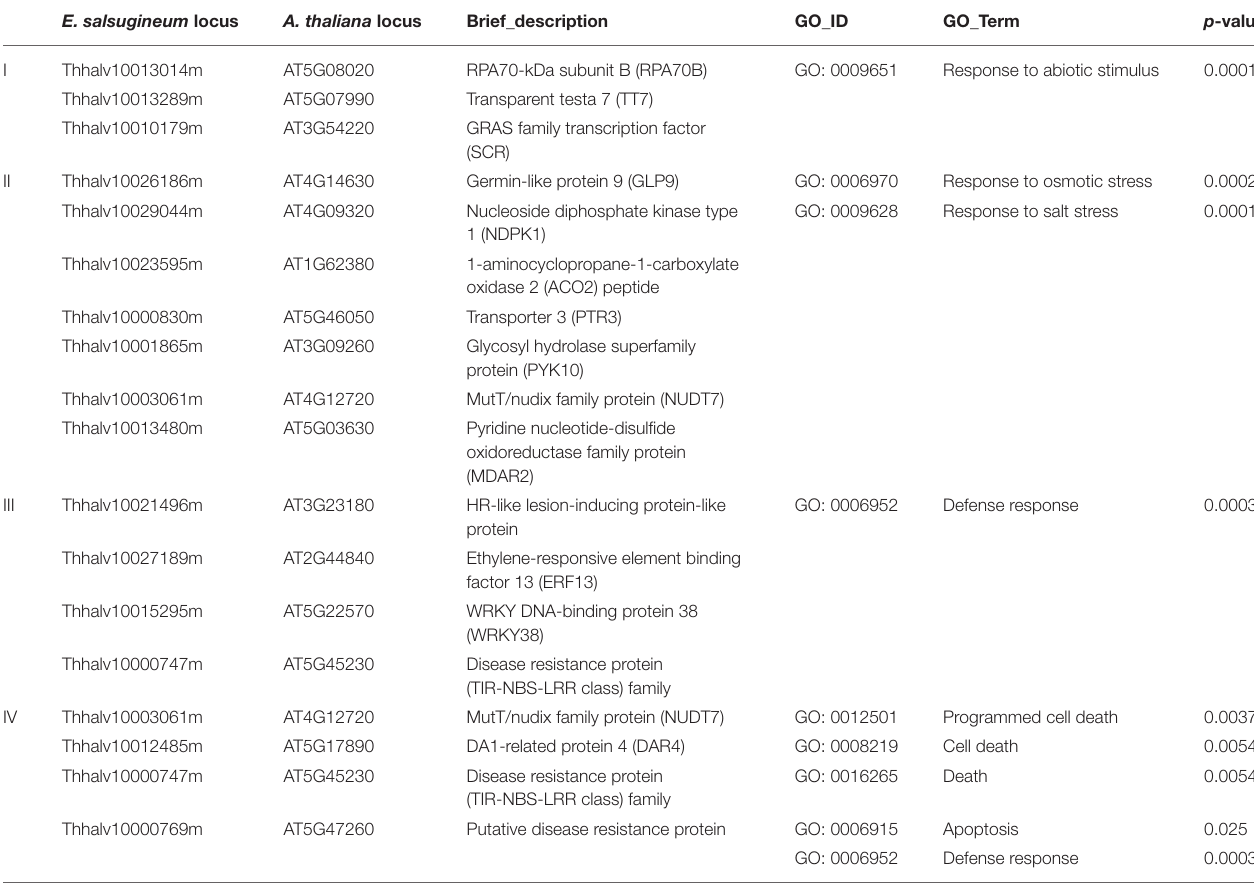
TABLE 1 | Gene ontologies (GOs) in the 16 putatively abiotic-biotic stress related genes of E. salsugineum ( p -value <